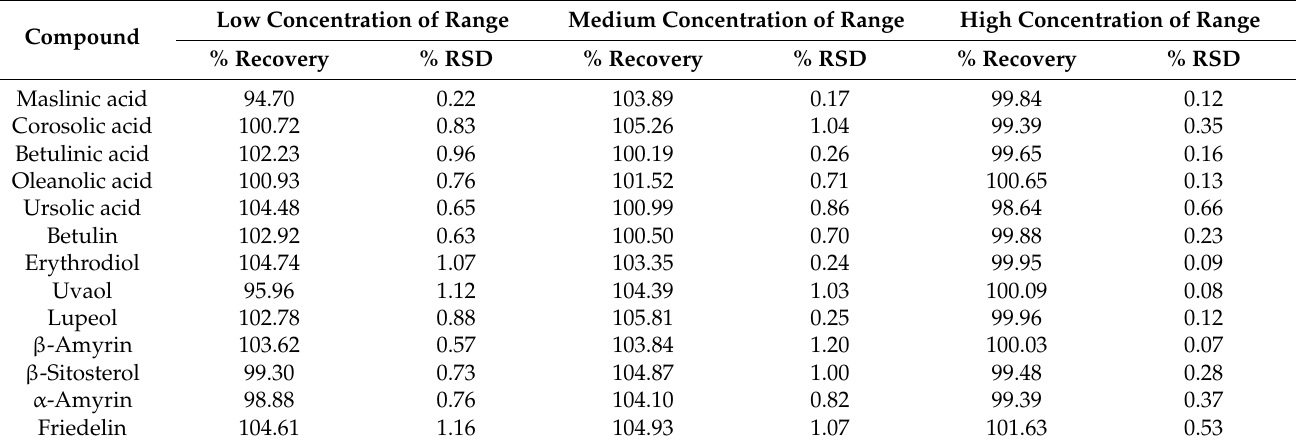
Table 3. Results of the recovery study of